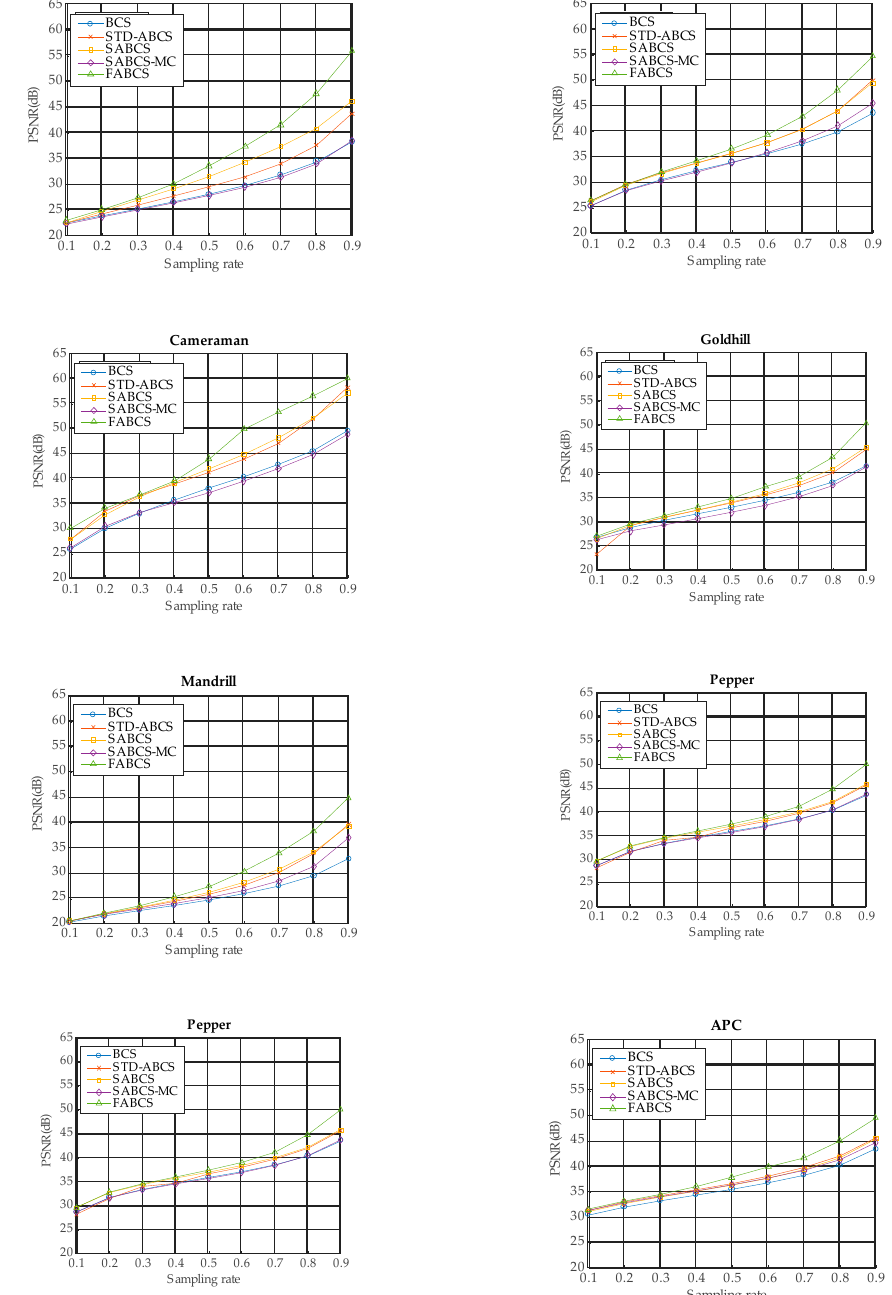
Figure 12. The experimental results for a block size of 32 ×